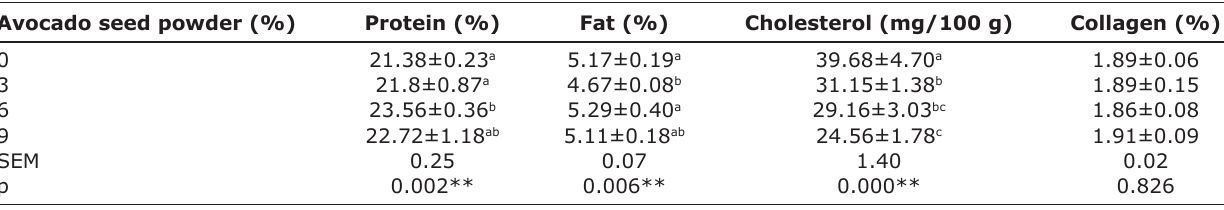
Table-4: Nutrient content of culled quail meat. Avocado seed powder